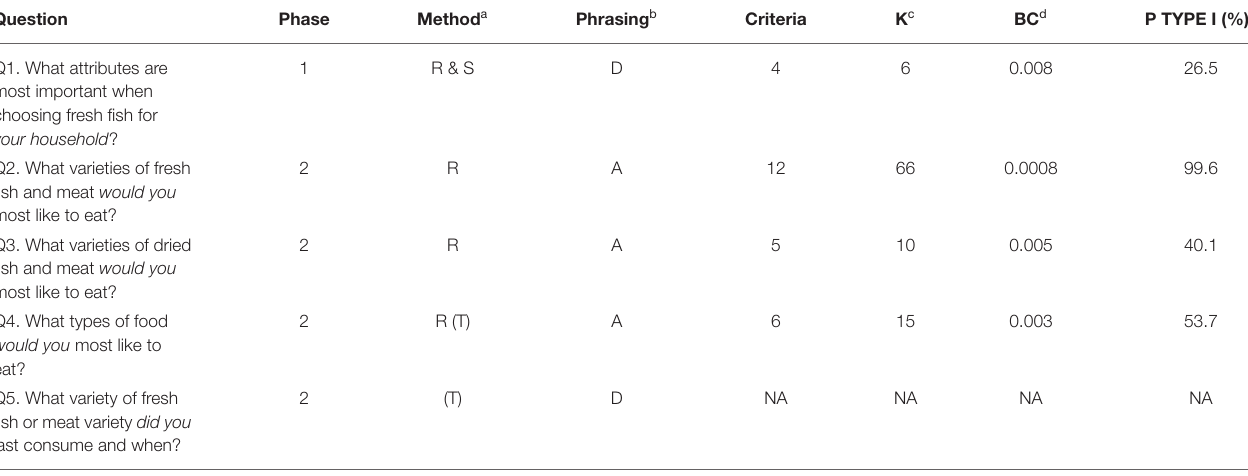
TABLE 4 | Characteristics of preference ranking, scoring and triangulation questions employed in phases 1 and 2 and family-wise error rates for pair-wise post-hoc tests. Question Phase Method a Phrasing b Criteria K c BC d P TYPE I (%) e